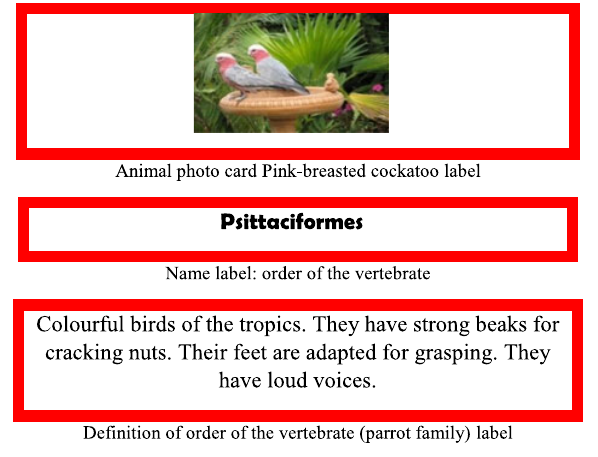
Fig. 5. Example of three types of labels: order of the vertebrates